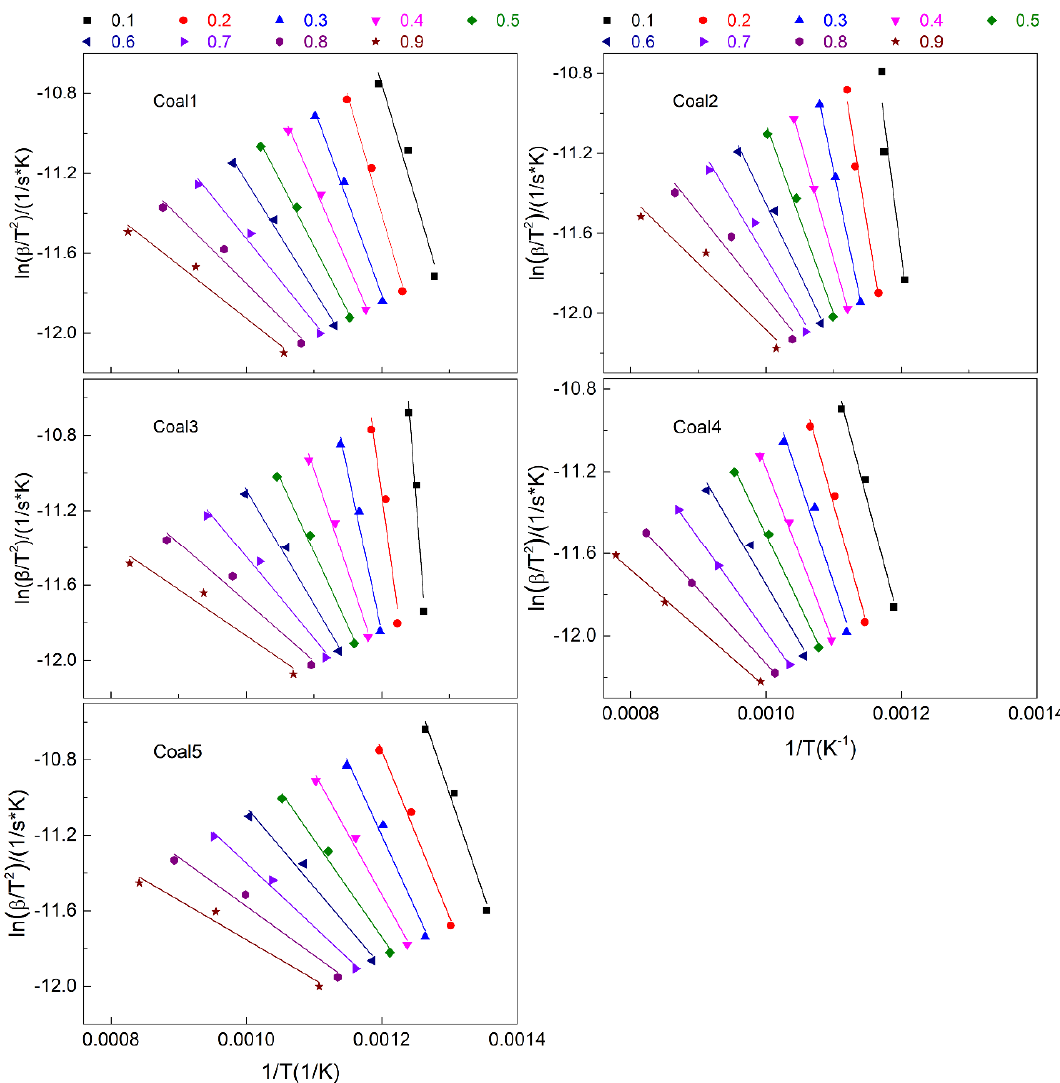
Figure 7. Arrhenius plots of bituminous coal samples at various conversion from α = 0.1 to α = 0.9. Table 3. Kinetic parameters of bituminous coal